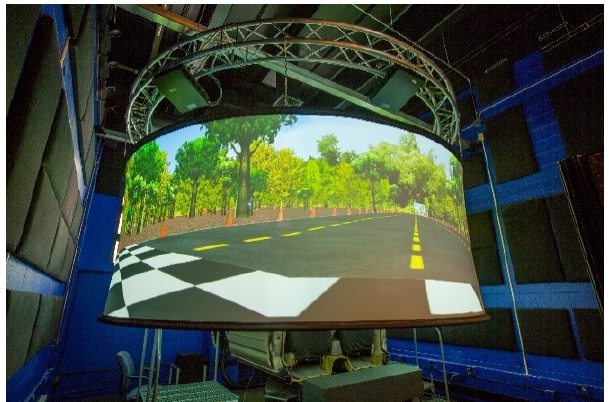
Figure 2. Fixed-base simulator.